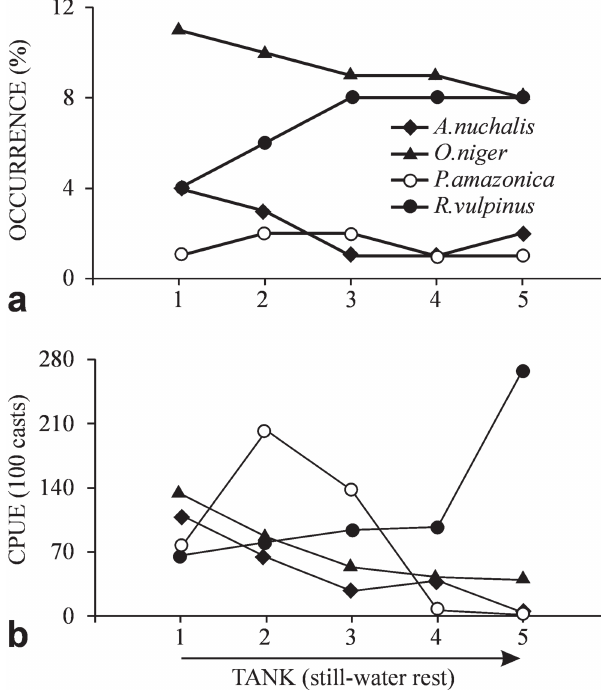
Fig. 2. Catch per unit effort of fish (CPUE; individuals per 100 casts) along the fish ladder at Lajeado Dam (Numbers in pa- rentheses = total number of species; gray light portions of columns indicate the proportion of Rhaphiodon vulpinus ; arrow indicates upward movement).